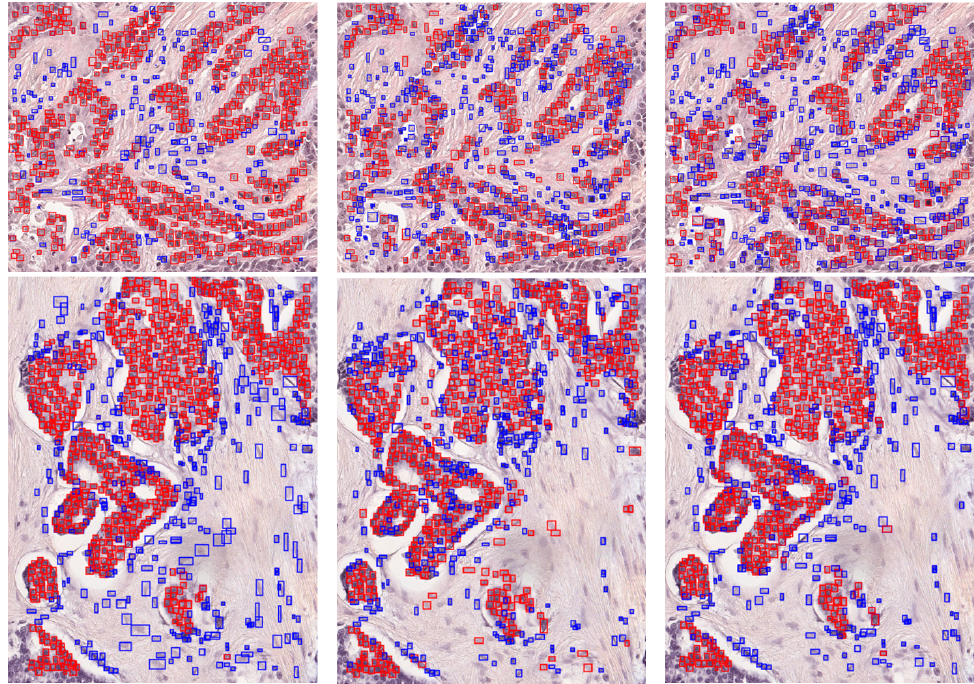
Figure 6. External validation visualization examples in QuPath. ( First column ) Ground truth. ( Second column ) D1C model. ( Third column ) D2C model. Blue: non-tumor nuclei; red: tumor